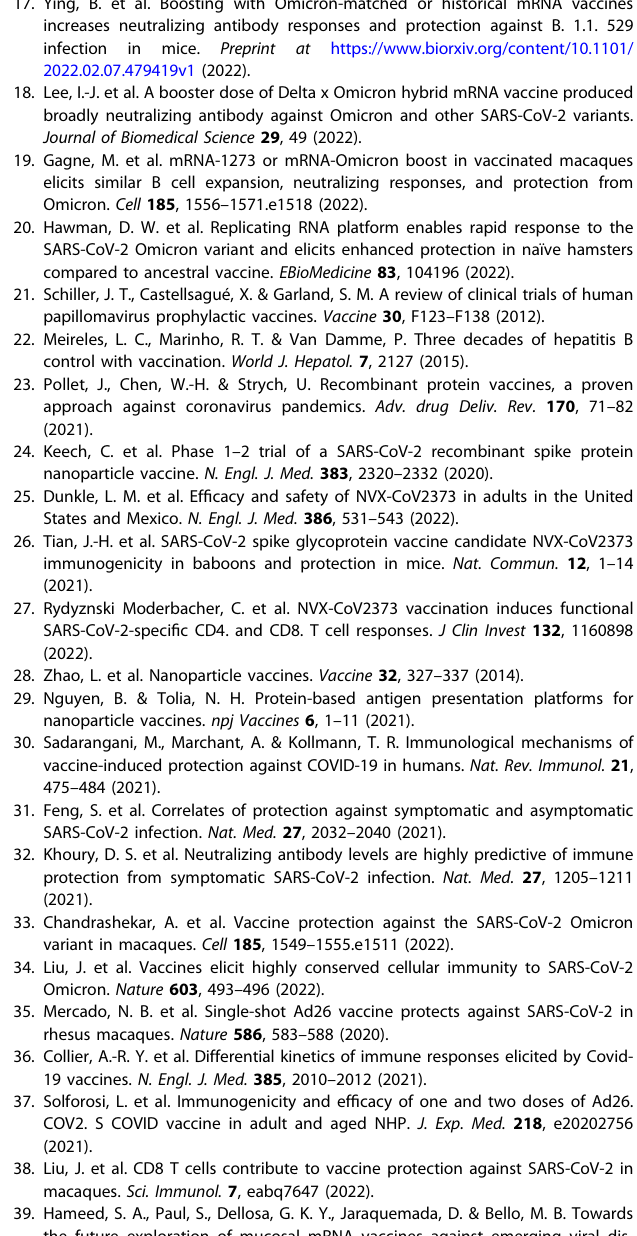
Fig. 6 Correlates of humoral responses and viral loads. Group 1 (open squares) received three sham doses, Group 2 (solid triangles) received three doses of GBP510-Wu, Group 3 (open diamonds) received two doses of GBP510-Wu and one dose of GBP510-SA, and Group 4 (solid circles) received two doses of GBH510-Wu and one sham dose. A The correlation between week 10 NAbs against WA1/2020 ( R = 0.8545, P < 0.0001, two-sided Spearman rank-correlation tests), Beta (R = 0.8663, P < 0.0001, two-sided Spearman rank-correlation tests), and Delta ( R = 0.8640, P < 0.0001, two-sided Spearman rank-correlation tests) vs the peak viral loads in the BAL after challenge with Delta SARS-CoV-2. B The correlation between week 10 NAbs against WA1/2020 ( R = 0.8573, P < 0.0001, two-sided Spearman rank-correlation tests), Beta ( R = 0.8026, P < 0.0001, two-sided Spearman rank-correlation tests), and Delta ( R = 0.8931, P < 0.0001, two-sided Spearman rank-correlation tests) vs the peak viral loads in the NS after challenge with Delta SARS-CoV-2. C The correlation between week 10 RBD speci fi c binding antibodies against WA1/2020 ( R = 0.8437, P < 0.0001, two-sided Spearman rank-correlation tests), Beta ( R = 0.8427, P < 0.0001, two-sided Spearman rank-correlation tests), and Delta ( R = 0.8499, P < 0.0001, two-sided Spearman rank-correlation tests) vs the peak viral loads in the BAL after challenge with Delta SARS-CoV-2. D The correlation between week 10 RBD speci fi c binding antibodies against WA1/2020 ( R = 0.8616, P < 0.0001, two-sided Spearman rank-correlation tests), Beta ( R = 0.8651, P < 0.0001, two-sided Spearman rank-correlation tests), and Delta ( R = 0.8641, P < 0.0001, two-sided Spearman rank-correlation tests) vs the peak viral loads in the NS after challenge with Delta SARS-